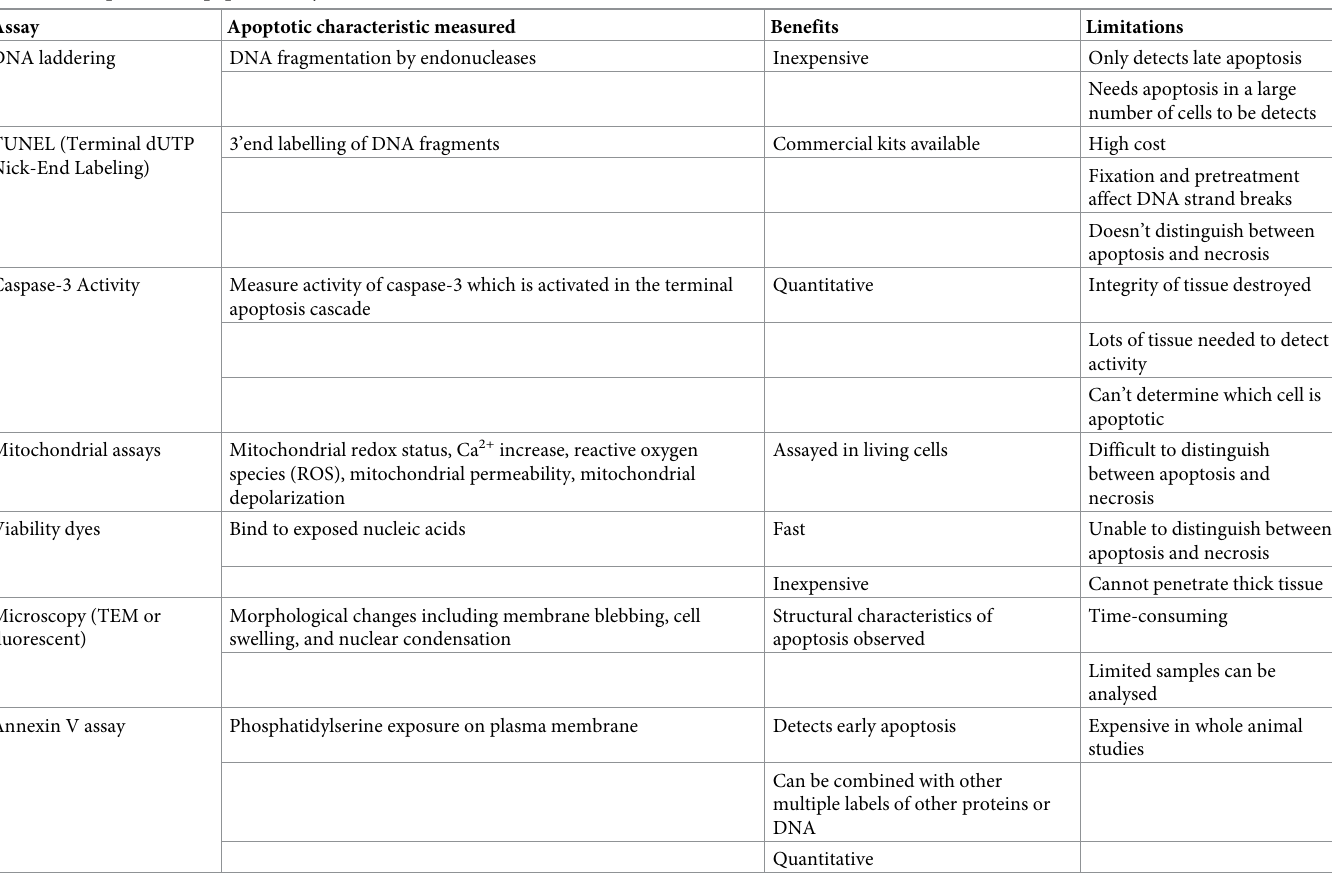
Table 1. Comparison of apoptosis assays.